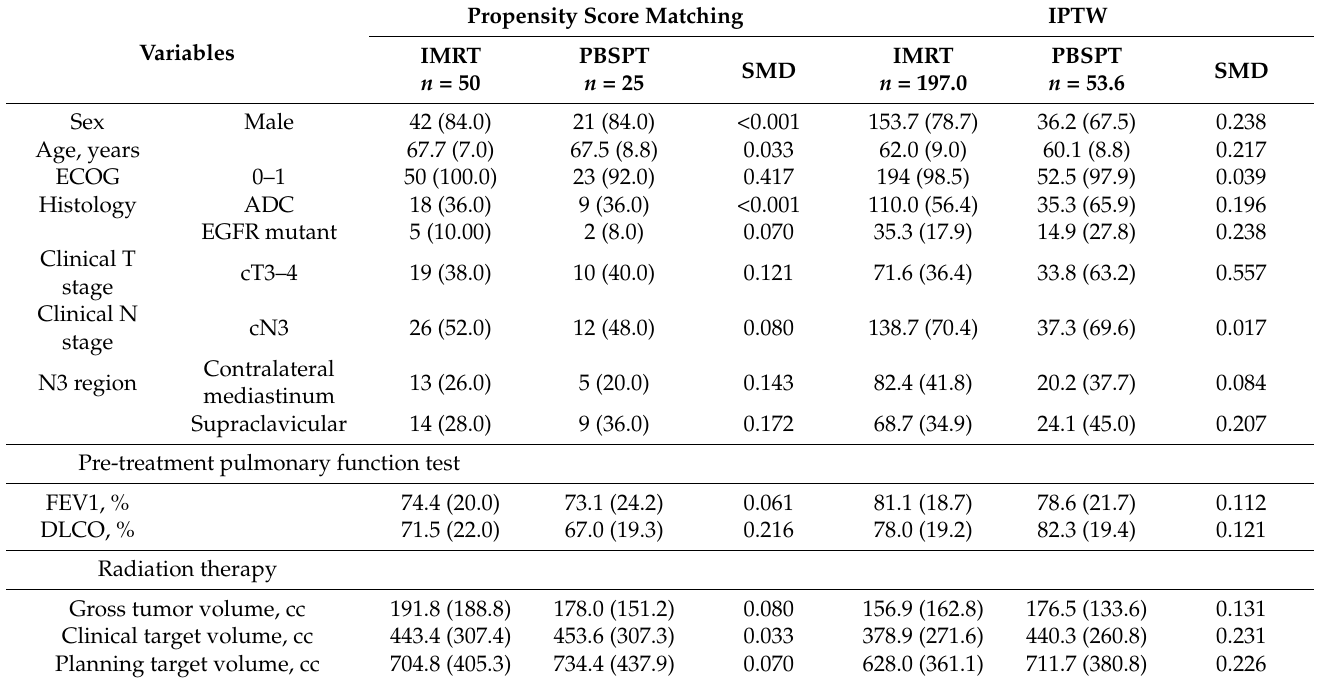
Table 5. Patient, tumor, and treatment characteristics after propensity score matching and